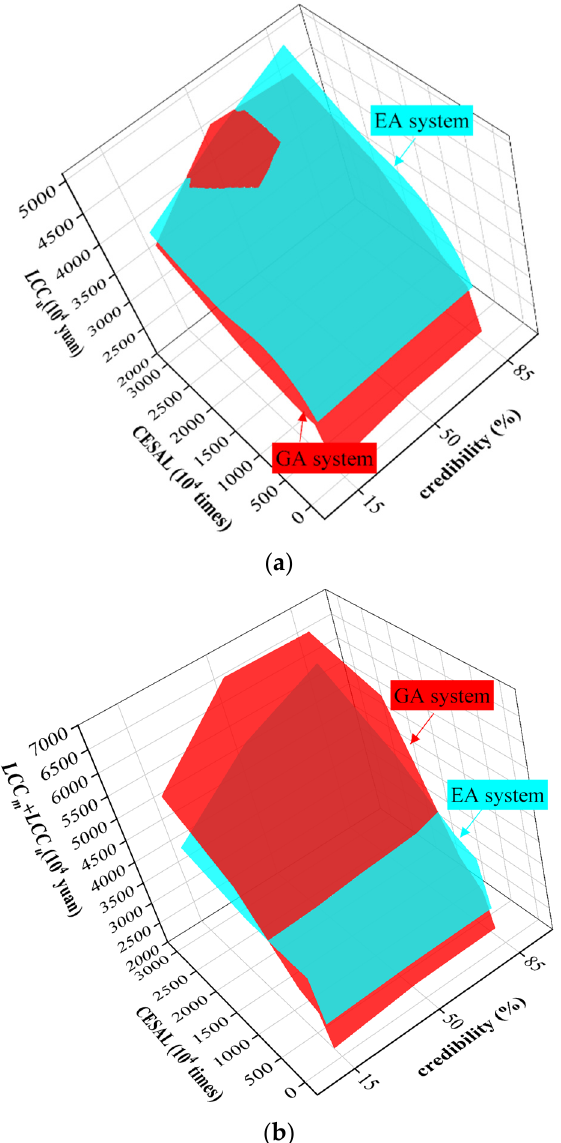
Figure 5. The LCC m and ( LCC m + LCC u ) of the EA system and the GA system under representative traffic conditions and different credibility: ( a ) LCC m ; ( b ) LCC m + LCC u ; CESAL = cumulative equivalent single axle loads; LCC m = manager cost; LCC u = user cost. Table 7. The conversion factors of user costs.